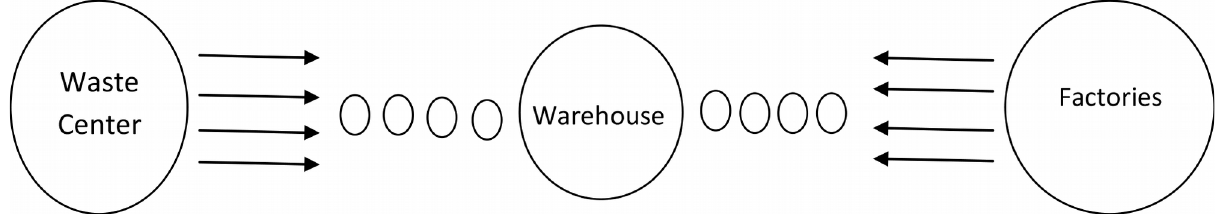
Figure 5. An example of a Queue formed at a center of the supply